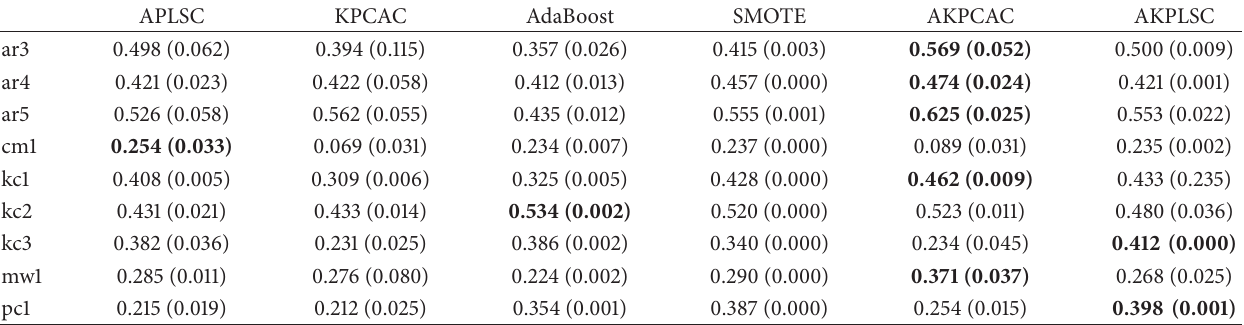
Table 3: Statistical 𝐹 -measure (mean ± std) values of six classifiers on all data sets. The value of the winner method of each row is emphasized in